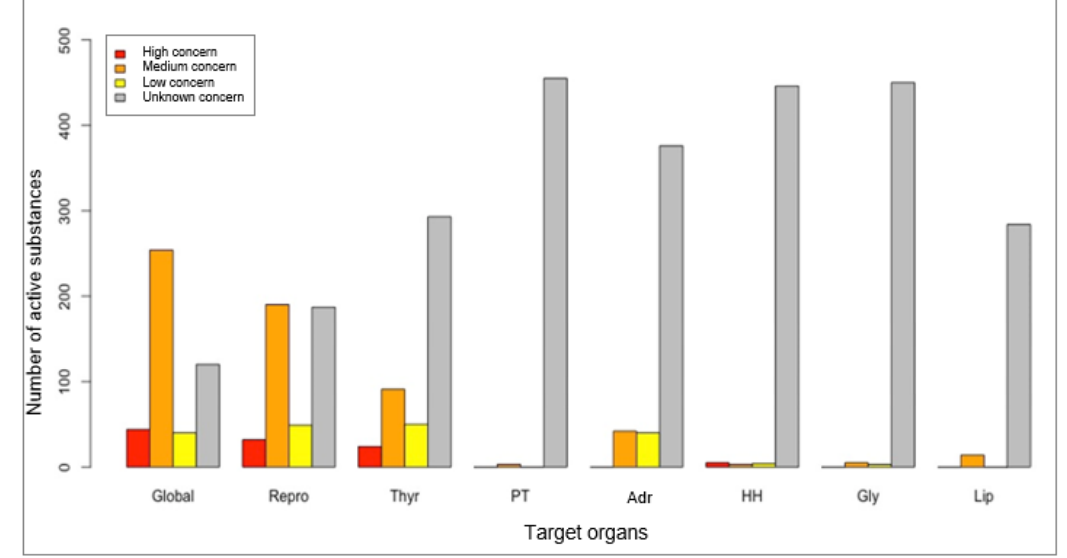
Figure 2. Number of phytopharmaceutical active substances by category of endocrine disruptor or target organ toxicity (ED/TEG) (Repro: reproduction organ, Thy: thyroid gland, PT: parathyroid glands, Adr: adrenal glands, HH: hypothalamic– pituitary complex, Gly: carbohydrate metabolism and pancreatic islets, Lip: lipid